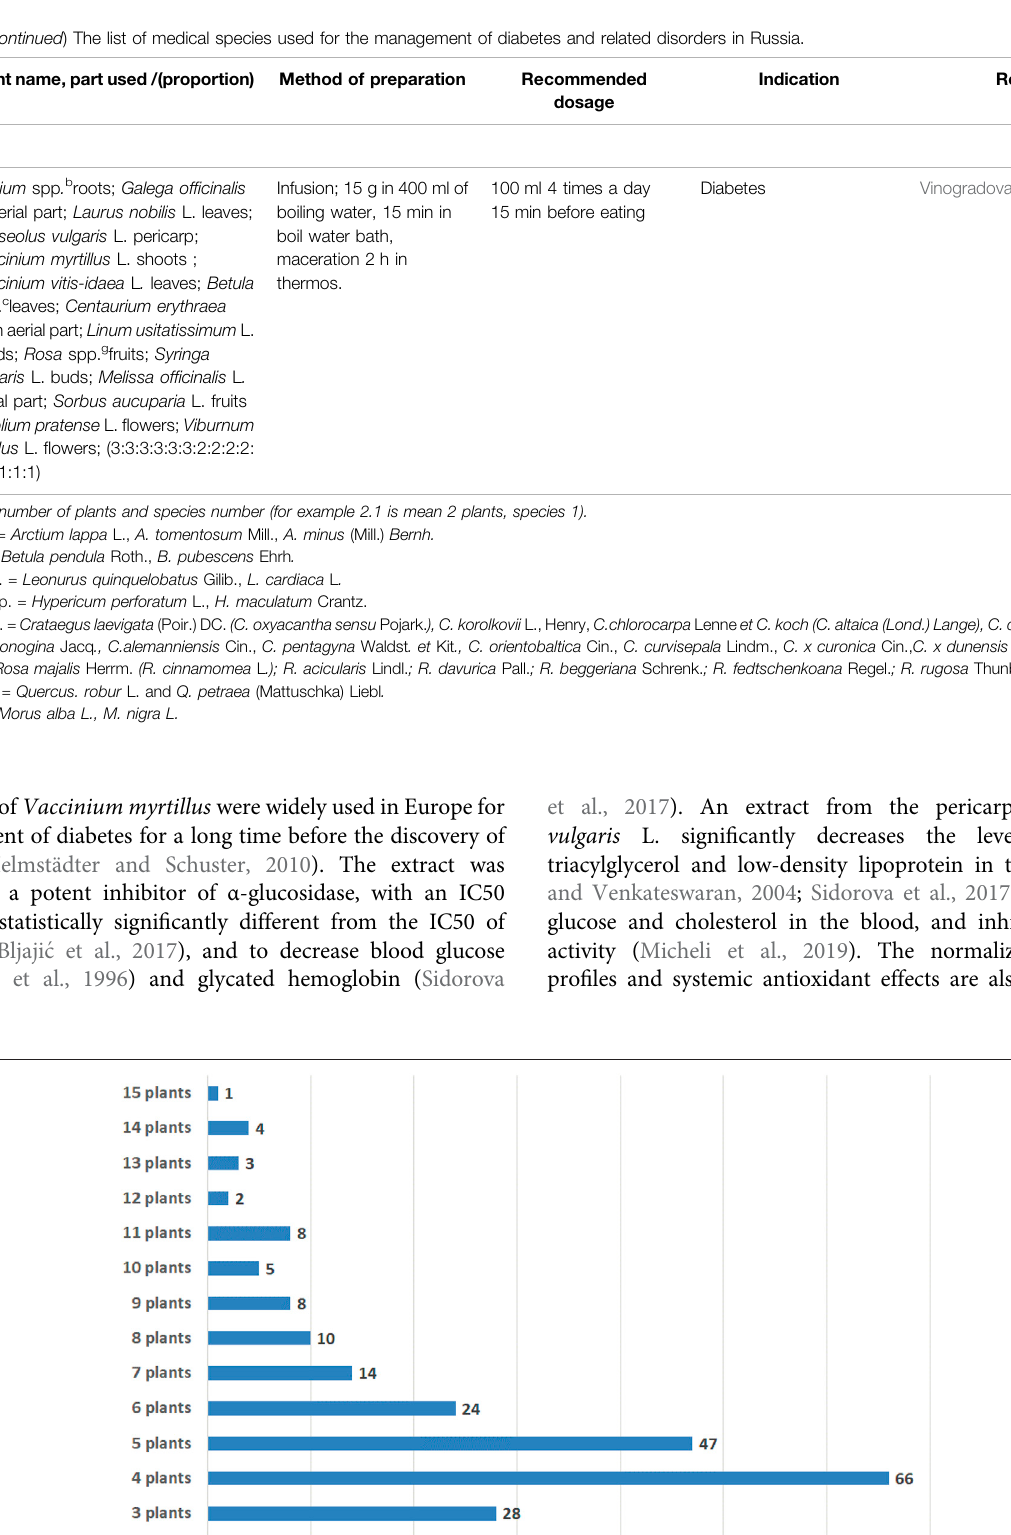
Frontiers in Pharmacology |